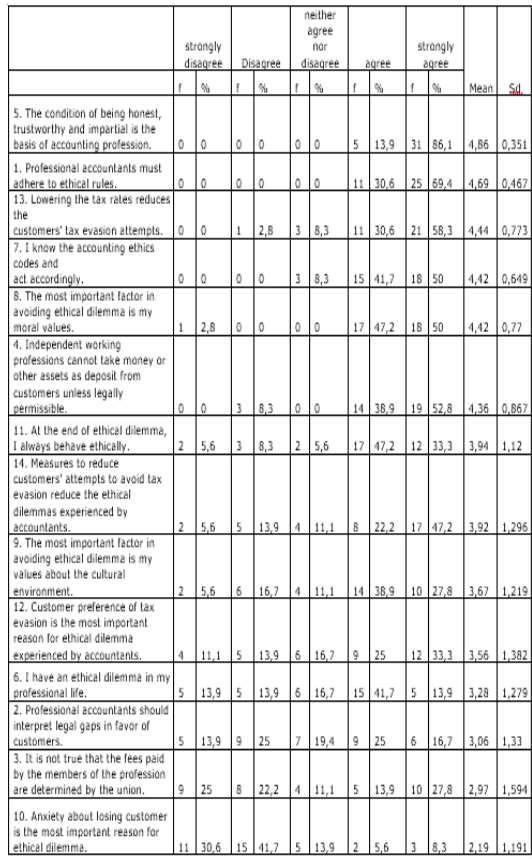
Table 17: Frequency Distribution for Ethics